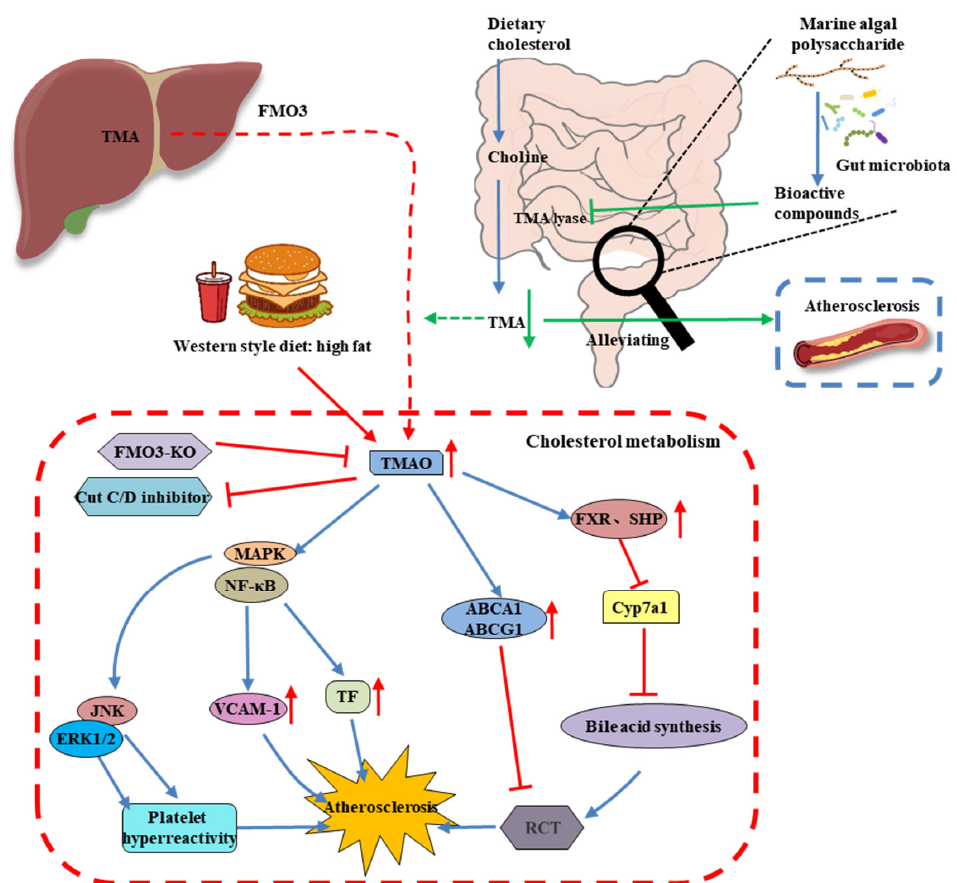
Figure 5. Dietary precursors, such as choline and L-carnitine, are metabolized into TMA by gut microflora through their related enzymes. Host hepatic FMO (flavin monooxygenases) oxidize TMA into TMAO, which promotes metabolic and functional changes in the host including CVD. Several gut microbiota are involved in TMA and TMAO formation, including De- ferribacteraceae, Anaeroplasmataceae, Prevotellaceae, and Enterobacteriaceae [83]. Chlo- rella pyrenoidosa and Spirulina platensis polysaccharides restored the HFD-induced de- crease in the relative abundance of gut bacterial TMA-producing enzymes and pathways [84]. Sargassum fusiforme fucoidan modulated the intestinal microbiota, especially by de- creasing the proportion of Proteobacteria to decrease the metabolism of carnitine and choline, thereby reducing the formation of TMA and TMAO [52]. 7. Conclusions and Future Perspectives Increasing research has shown that modulation of intestinal flora composition and function plays a pivotal role in the prevention and treatment of CVD. Recent studies have provided evidence that MAPs are beneficial for human health and nutrition. MAPs have received significant attention as dietary polysaccharides for manipulating the gut micro- biome. This review summarized the beneficial effects of MAPs on CVD by balancing the gut microbiota. MAPs are inclined to increase the abundance of Bacteroides, Akkerman- sia, Bifidobacterium, and Lactobacillus, while reducing Firmicutes and the Firmicu- tes/Bacteroidetes ratio to prevent or treat CVD. In addition, the profitable effects on heart health seem to be modulated by the secondary metabolites generated by the intestinal microbiota. SCFAs have been shown to modulate the cell signaling pathways involved